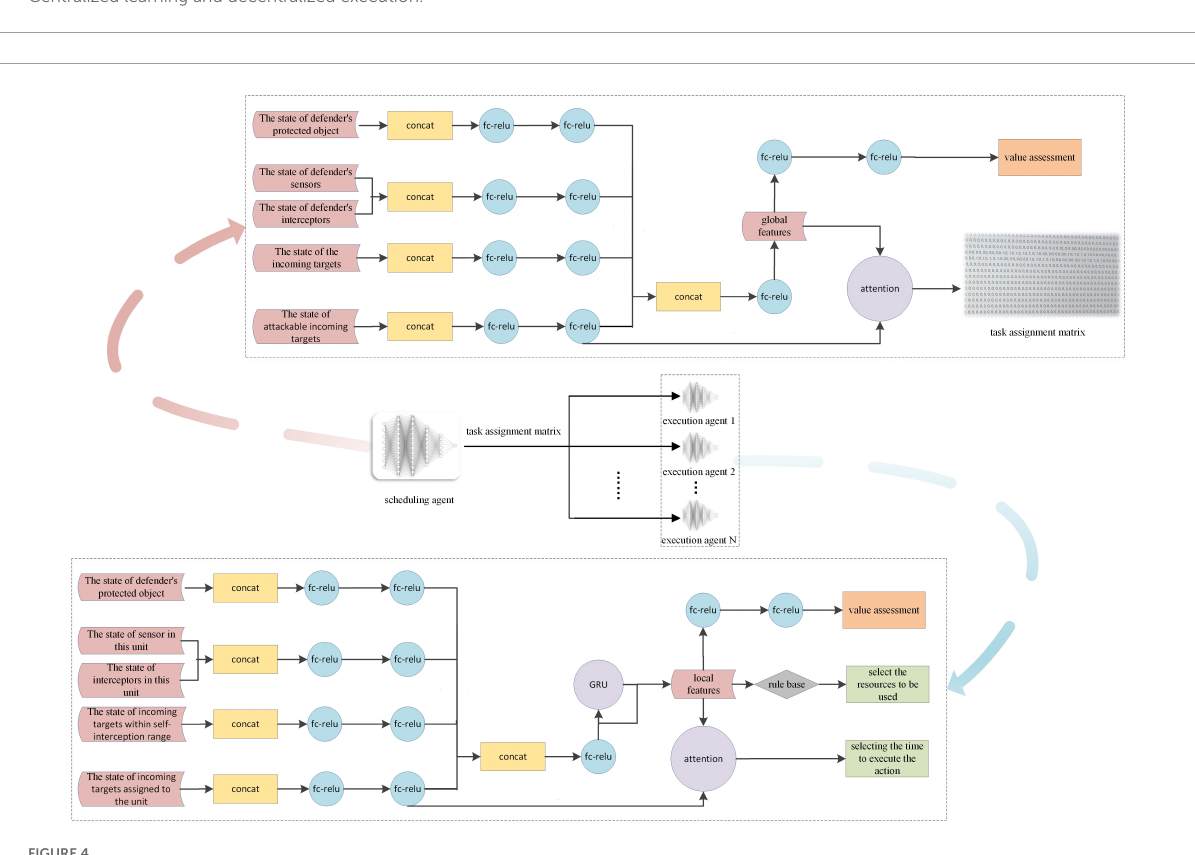
FIGURE4 Network structure.